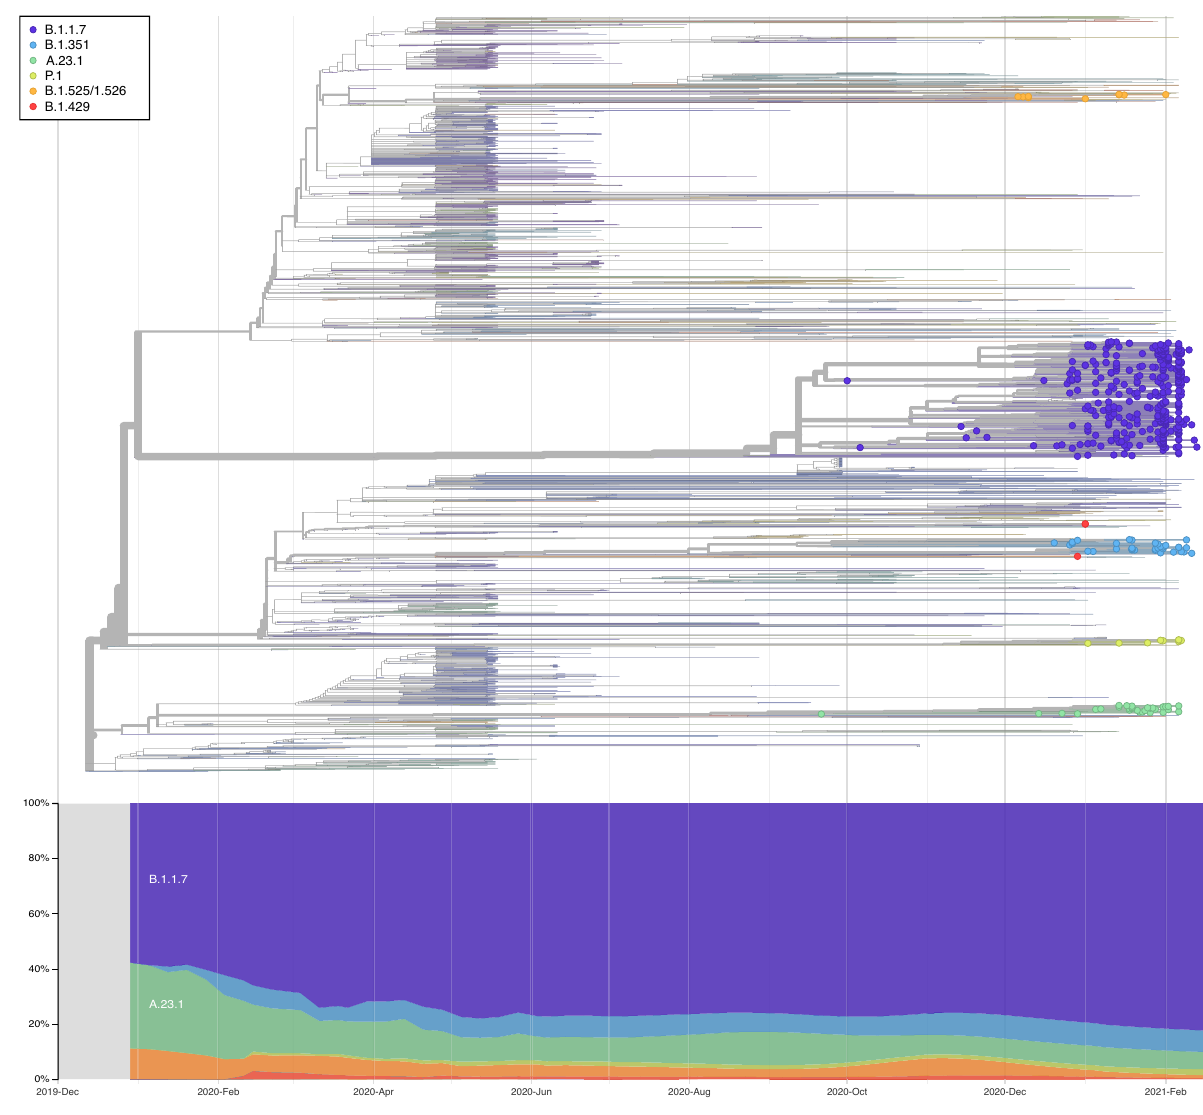
Figure 1. Time-scale Phylogenetic tree of the SARS-CoV-2 lineage in the UAE (shown as circles) from 25 April 2020 to 15 February 2021, contextualized with 1993 most similar sequences selected from